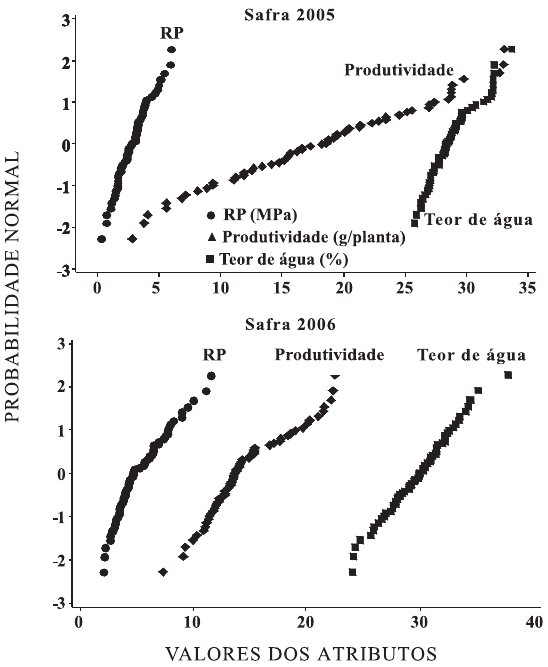
Figura 1. Probabilidade normal para as distribuições dos atributos em estudo no plantio direto irrigado, nas safras de 2005 e 2006.